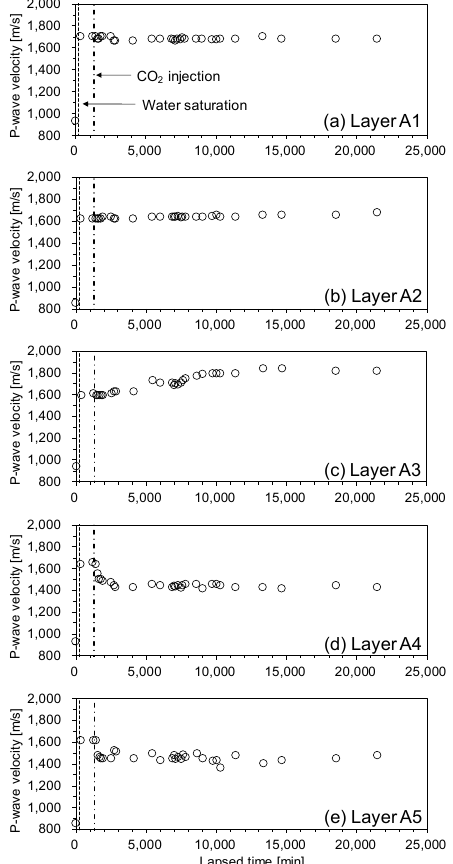
Figure 6. P-wave velocity of the unconsolidated sediment sample during CO 2 injection. ( a ) layer A1, ( b ) layer A2, ( c ) layer A3, ( d ) layer A4, ( e ) layer A5. P-wave velocity of layers A1 and A2 did not change during CO 2 injection because the CO 2 hydrate-bearing sediment layer prevented the upward flow of CO 2